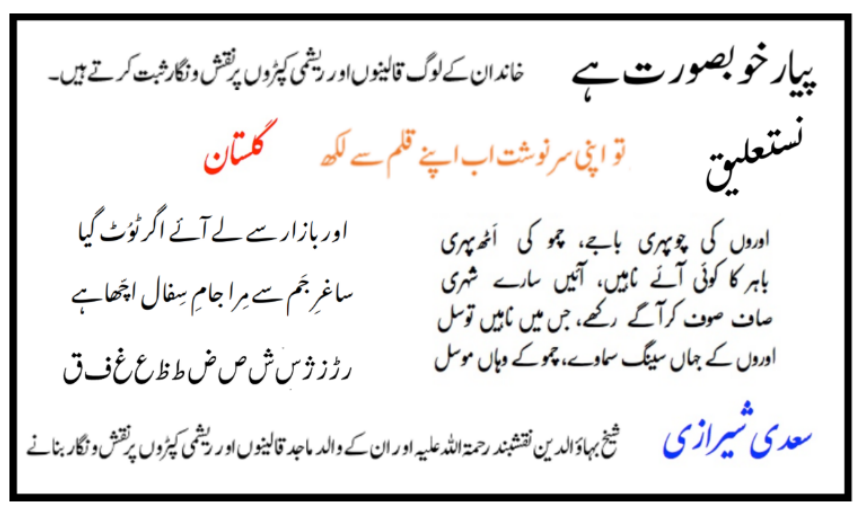
Figure 2. Nastaleeq font in different styles, colors and